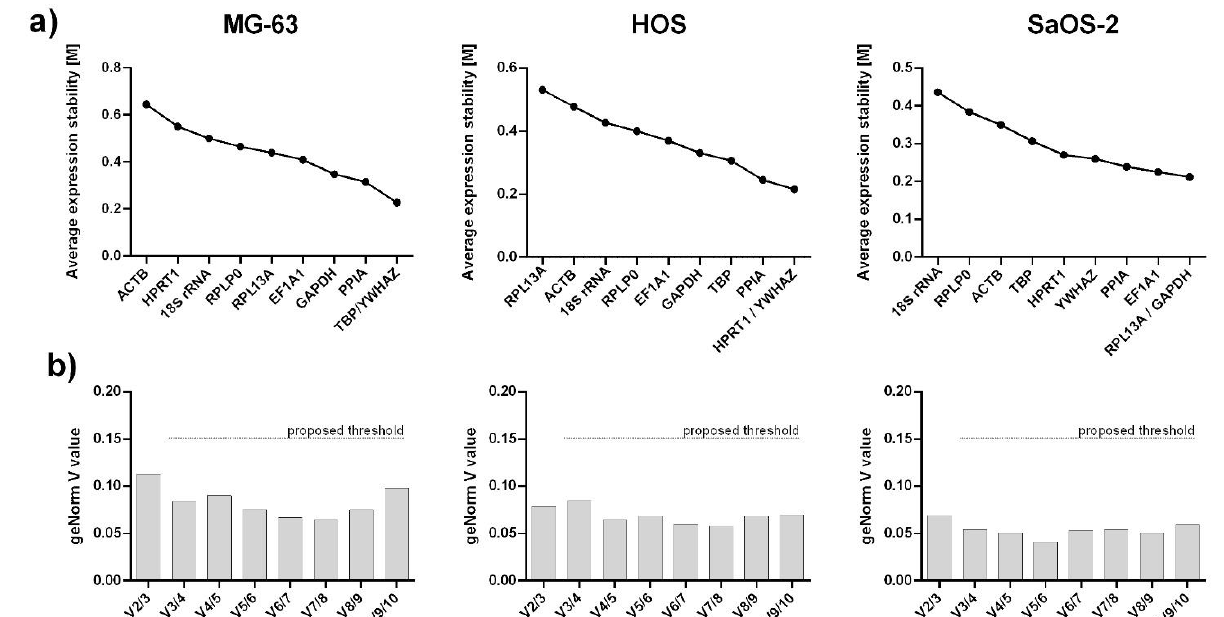
Figure 3. Stability of candidate internal control genes as determined with geNorm. ( a ) Gene ranking based on M value as a measure of gene stability (average pairwise variation of a particular gene with all other control genes; lower M value indicates higher stability). ( b ) geNorm’s pair-wise variation analysis for determination of minimal number of required genes for reliable normalization.